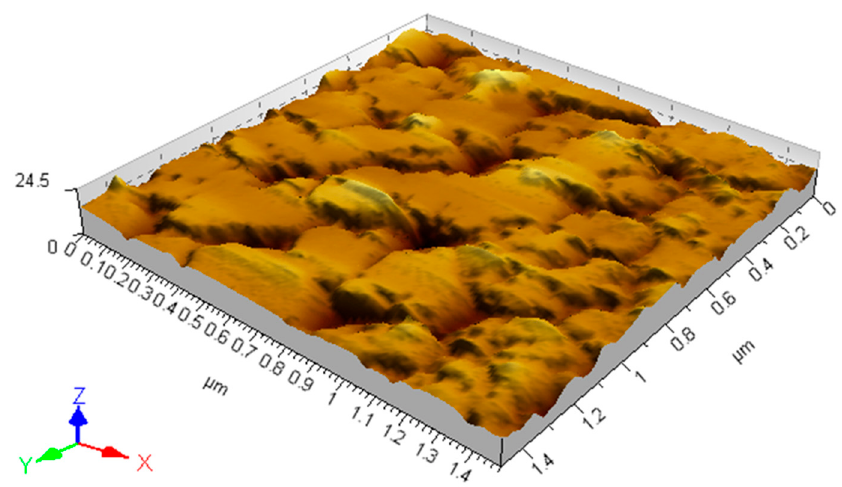
Figure 7. The topography of worn a-C surface under the lubrication of ZrO 2 -NPs dispersion.